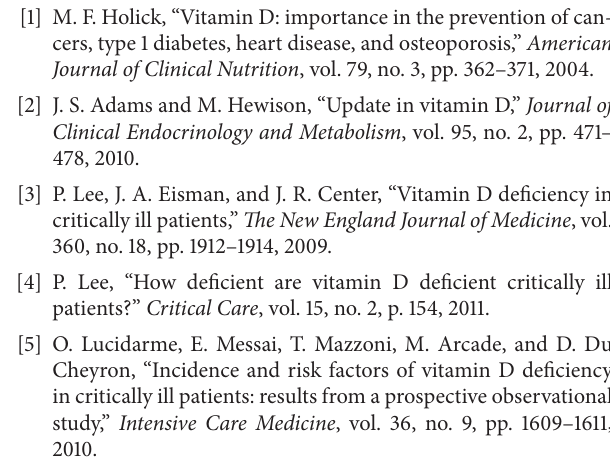
Table 5: According to multivariate analysis, independent risk factors for ICU mortality ∗